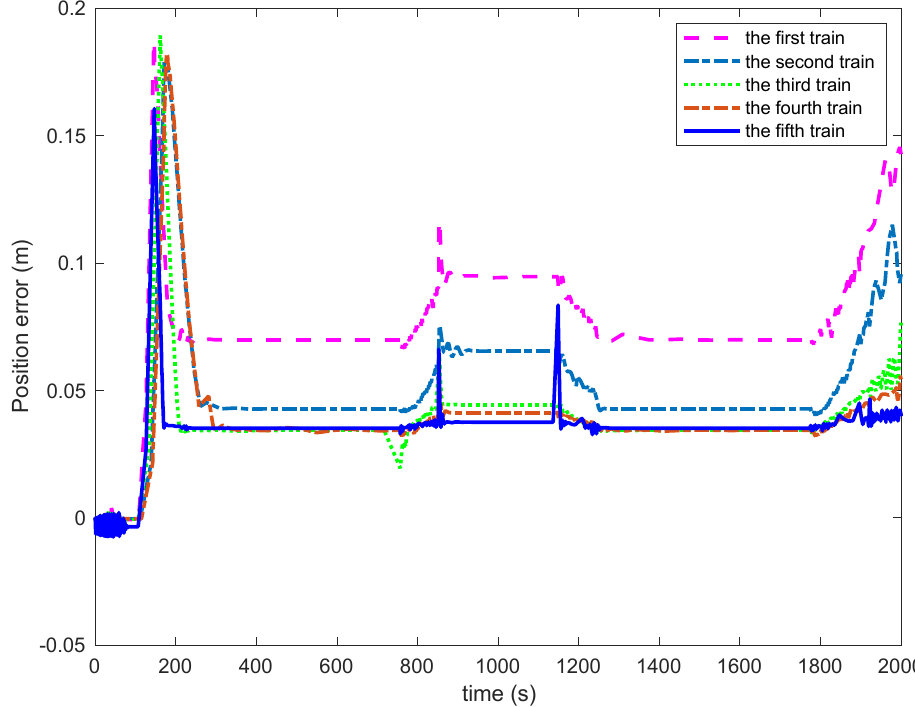
Figure 9. Position tracking error curves for single-value learning.